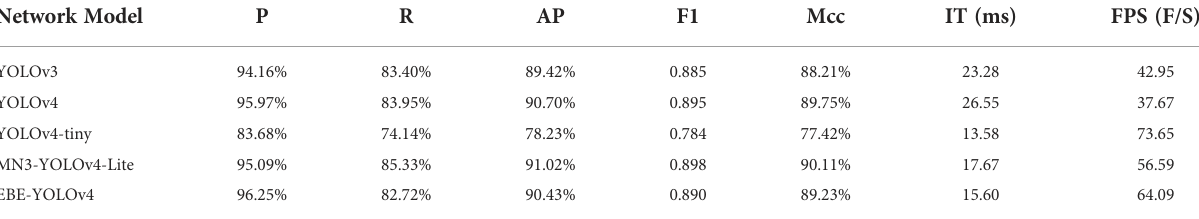
TABLE 6 Comparative experiments. Network